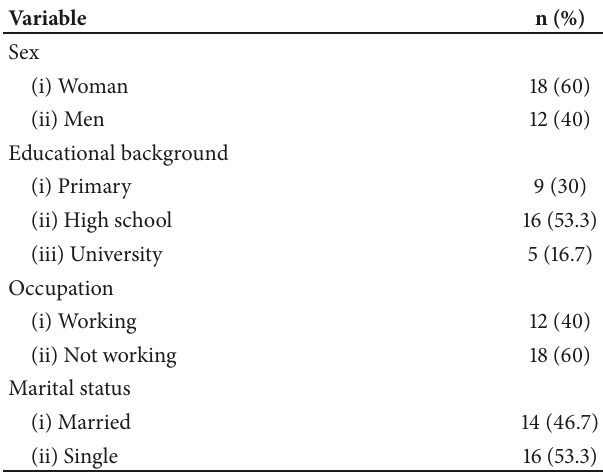
Table 1: Subjects Demographic Features for Validation